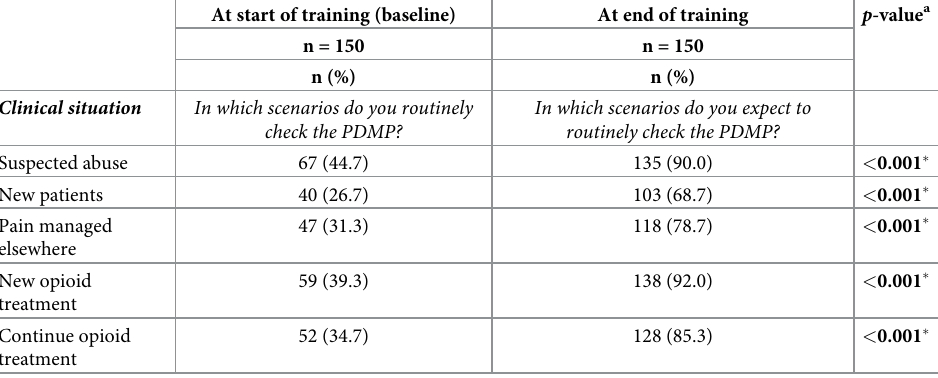
Table 2. Self-reported situation-specific PDMP use at start of training and at end of training in all participants completing the